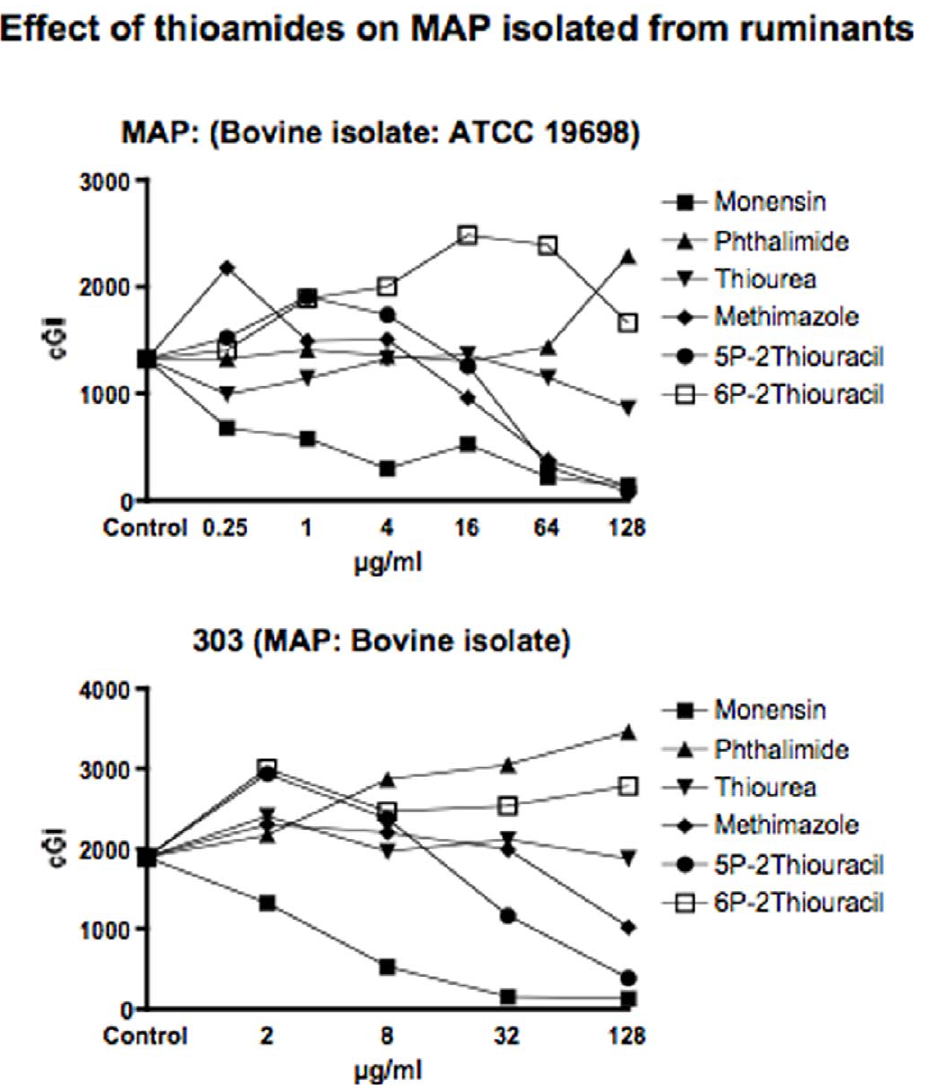
Figure 2. Shown are the cumulative Growth Indices (cGI) for the two MAP strains isolated from ruminants with Johne disease. The positive control is Monensin, and the negative control is Phthalimide. Note that 5-PTU is consistently the most effective agent, and 6-PTU exhibits no inhibition. Methimazole inhibits growth. Thiourea does not inhibit MAP 303.